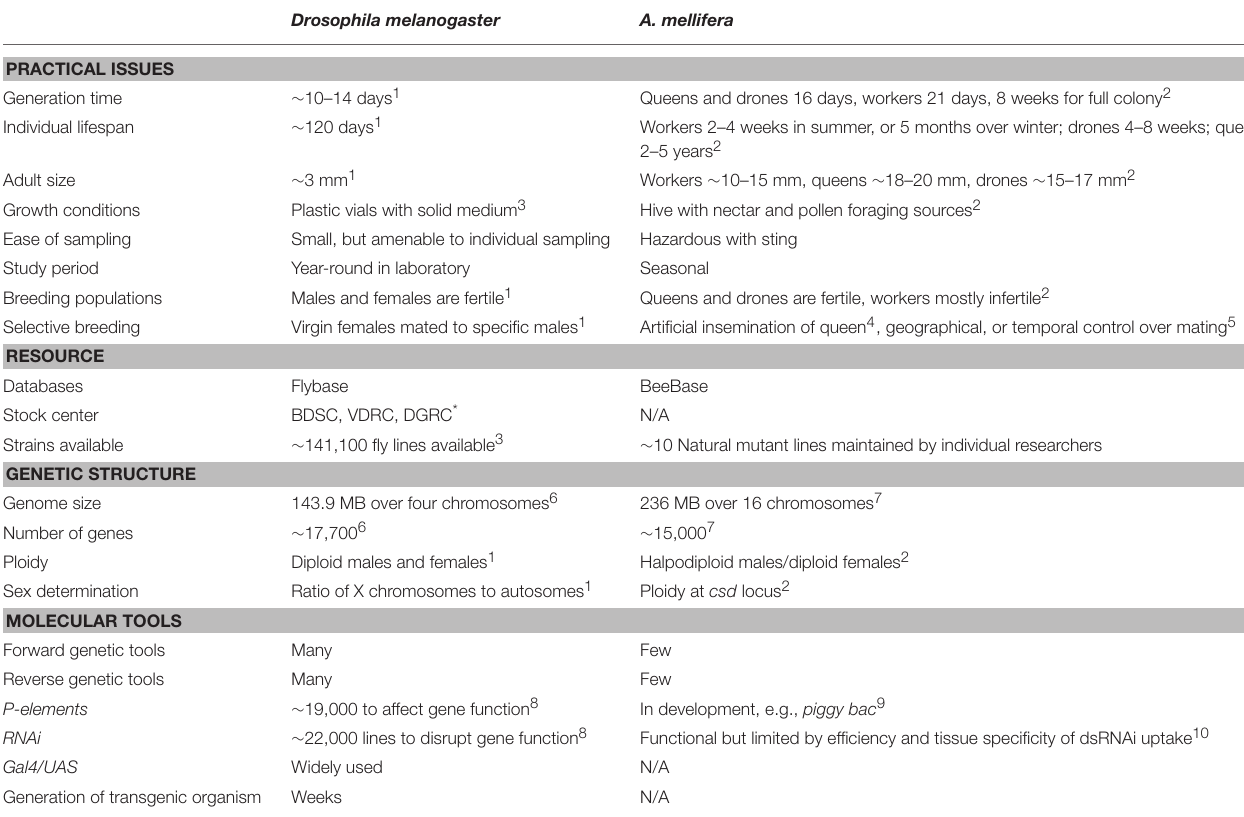
TABLE 1 | Overview of Drosophila and Apis insect model characteristics for social gene discovery. Drosophila